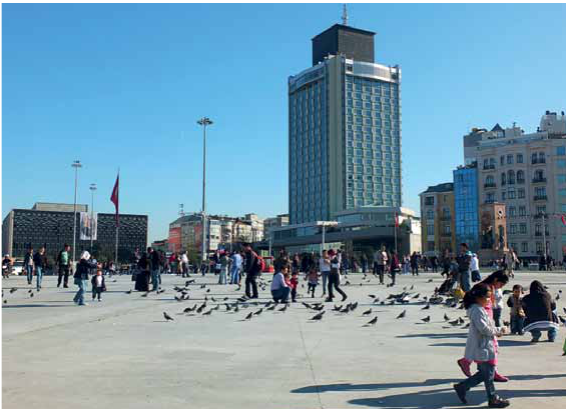
fig. 7. Taksim Square after vehicular roads have been placed underground. C. n. Cünük